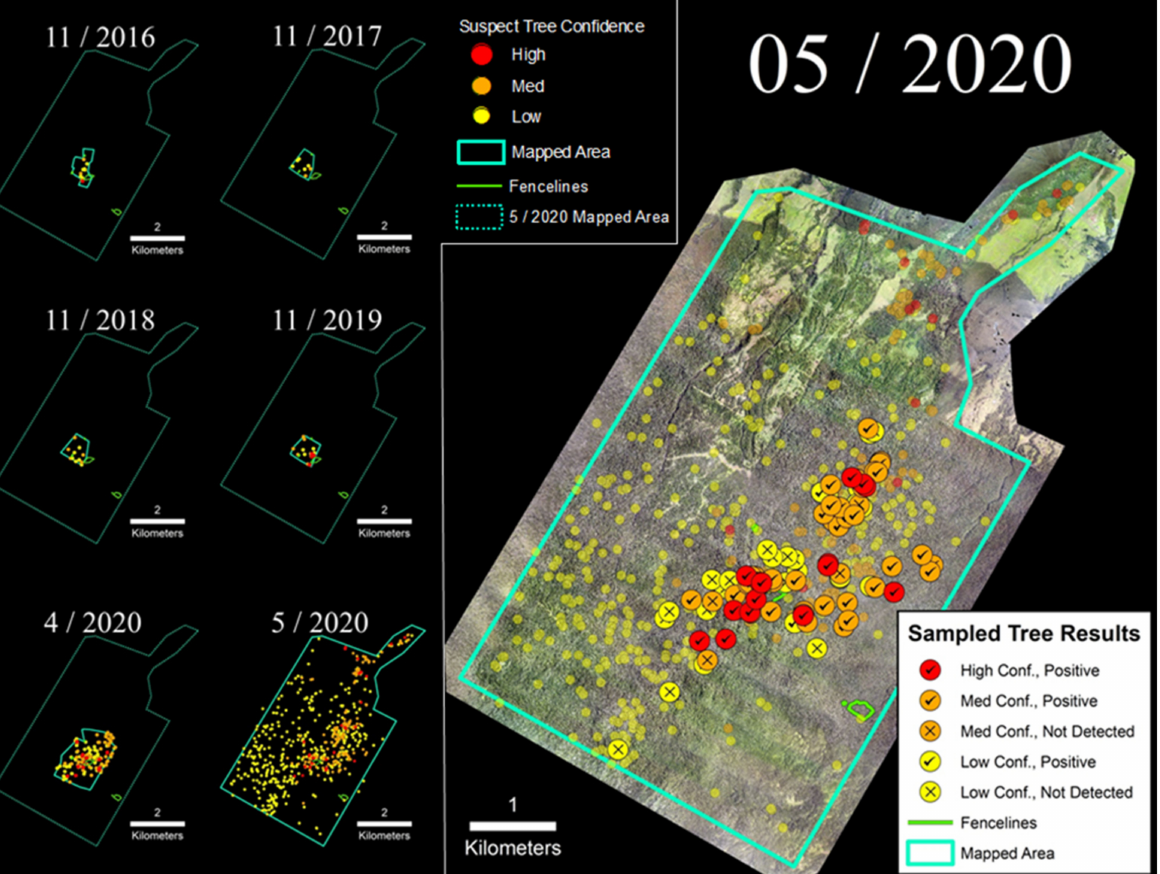
Figure 5. ( Left ) Time-series sequence of suspect trees for the LFR. ( Right ) Sampled trees and corresponding laboratory results; non-sampled suspect trees appear as semi-transparent background